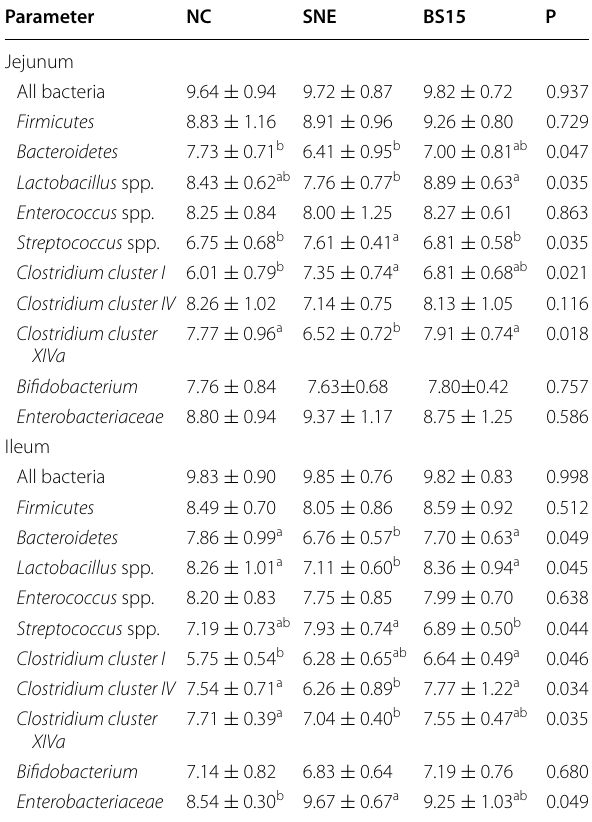
Table 6 Effect of Lactobacillus johnsonii BS15 on the gut